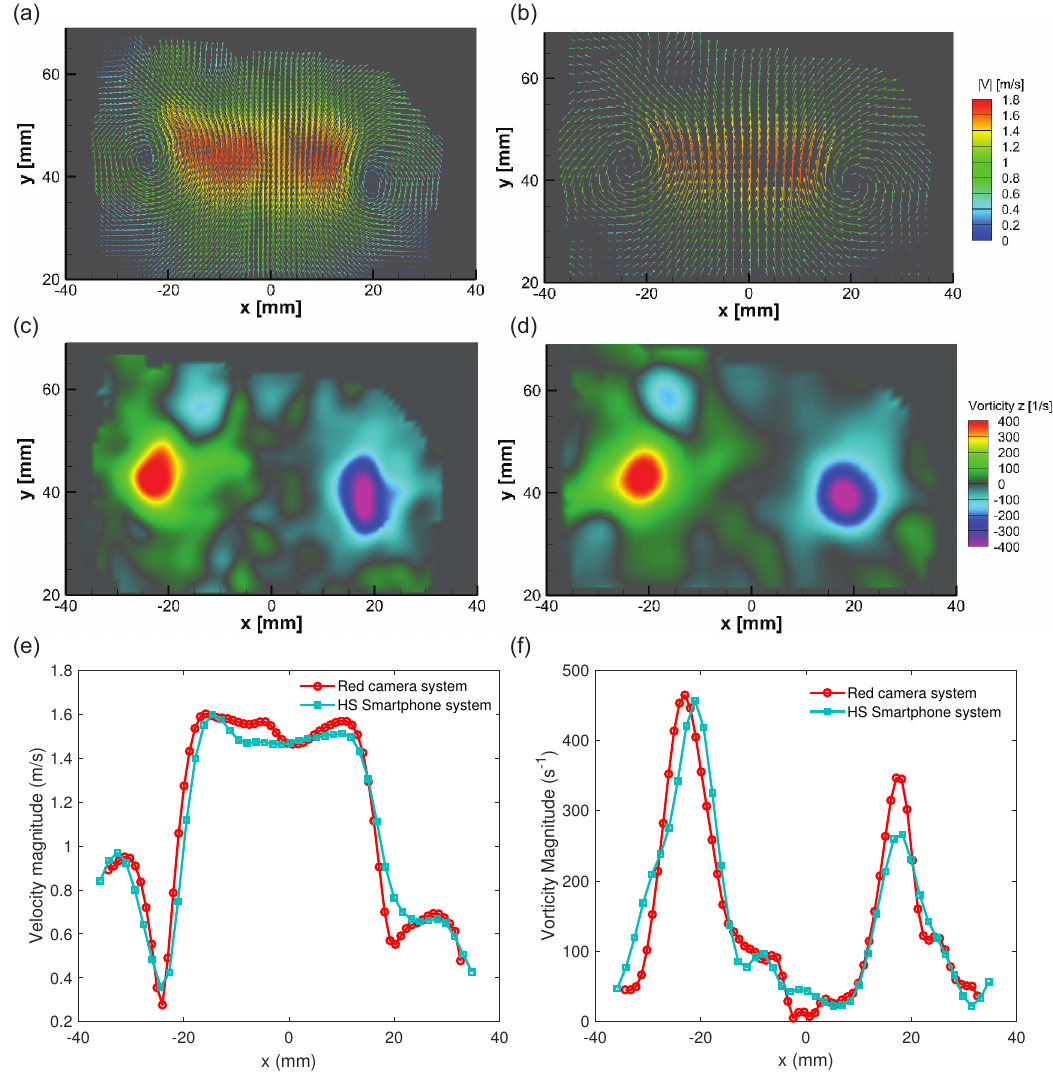
Figure 9. ( a , b ) Side by side comparison of velocity vectors colored by velocity magnitude on the center xy plane for ( a ) high-resolution RED camera system and ( b ) high-speed smartphone camera system. ( c , d ) Contour plots of vorticity magnitude are presented for ( c ) the high-resolution camera system and ( d ) the high-speed smartphone camera system. Visually one can notice the difference in spatial resolution of the two systems. ( e , f ) Comparison of the results along y = 44 mm, ( e ) velocity magnitude and ( f ) vorticity magnitude. The red lines represent the results obtained from the RED Cinema camera system. Cyan curves represent the results by the “slow-mo” smartphone